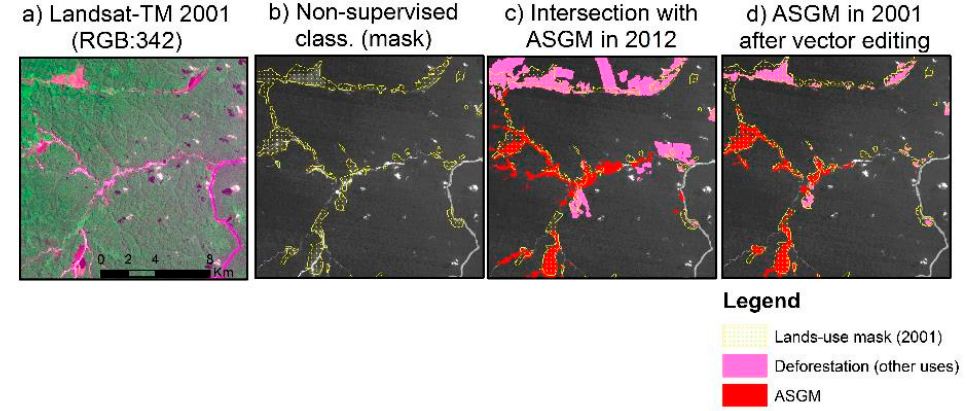
Figure 7. Mapping mining areas (and deforested areas that are not mining) using Landsat historical images (2001, 1993, 1984, and 1973). Satellite image database in 2001 (R/G/B:Red/NIR/Green band) ( a ) was submitted to an unsupervised classification where all land use classes, except forest, are included into one class, creating a land use mask 2001 (in yellow ) ( b ). This mask was then intersected with the MapASGM-2012 ( c ) followed by a vector editing in order to include all mining ( red polygons) and deforested areas ( pink polygons) in 2001 resulting in the MapASGM-2001 ( d ). The same procedure was applied to the imagery Landsat-TM database in 1993, 1984, and Landsat-MSS data in 1973.